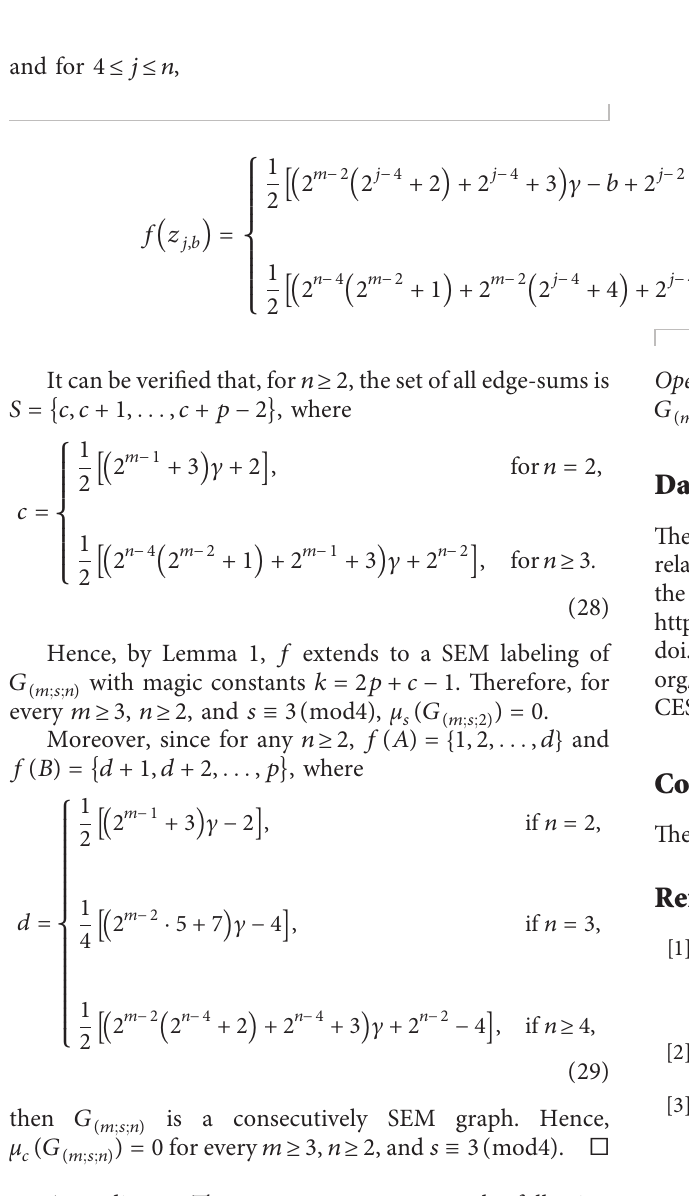
Figure 3: The (consecutively) SEM labelings of DT ( 2 , 1 , 2 , 4 , 8 ; 1 ; 9 , 8 ) and DT ( 2 , 1 , 2 , 4 , 8 ; 1 ; 9 , 8 , 10 , 12 )